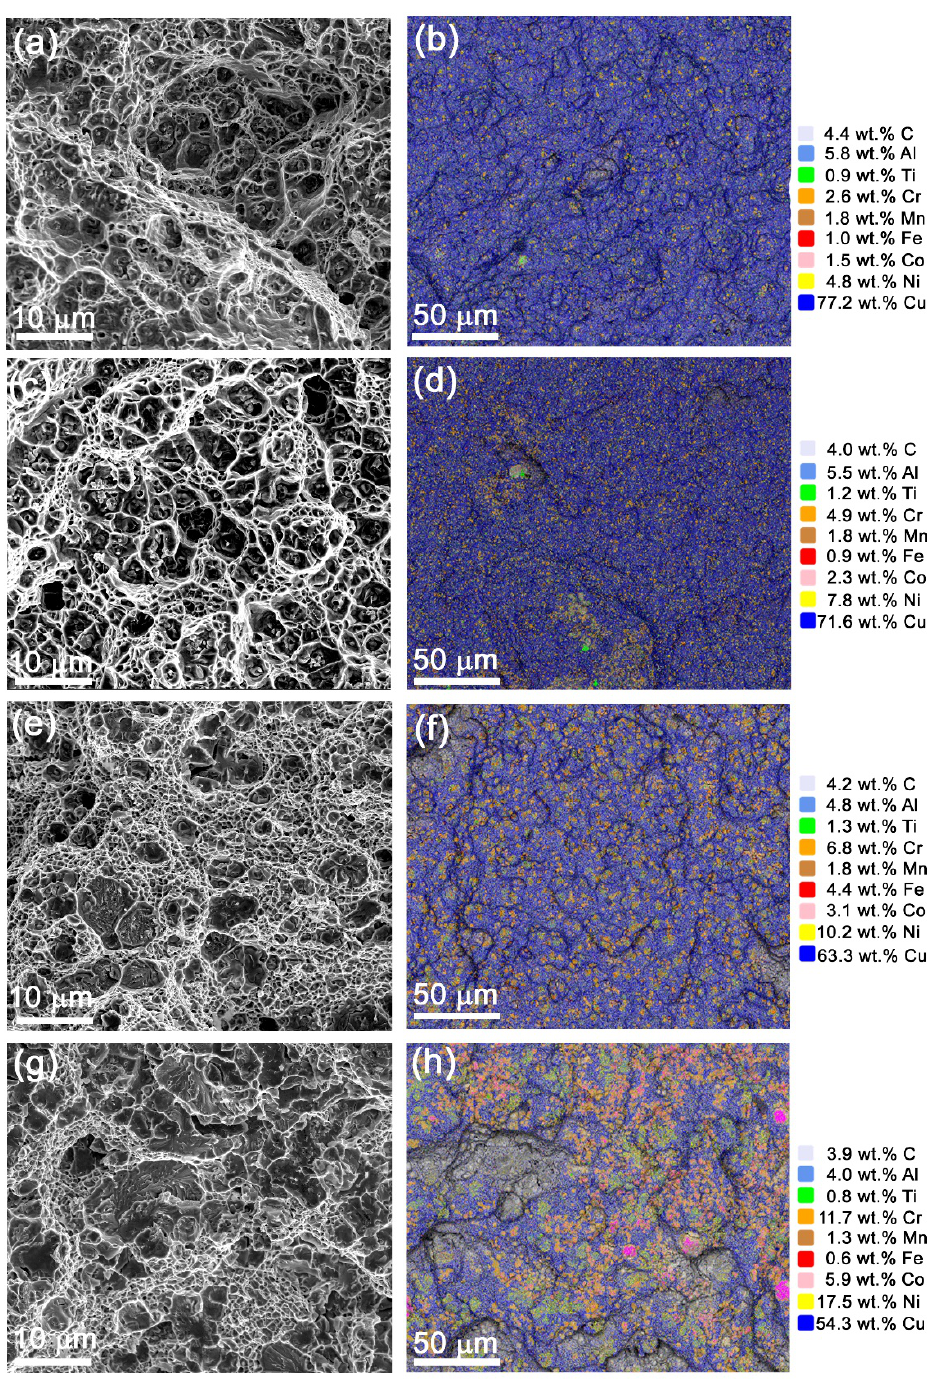
Figure 14. SEM SE fracture surface images of composites ( a ) 5% Ud, ( c ) 10% Ud, ( e ) 15% Ud and ( g ) 25% Ud and corresponding EDS element distribution maps ( b , d , f , h ).